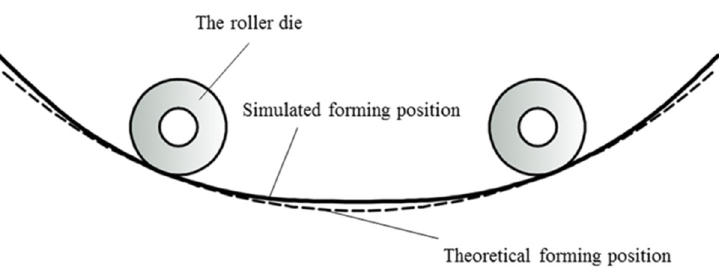
Figure 14. The schematic diagram of theoretical bending position and simulated bending position.